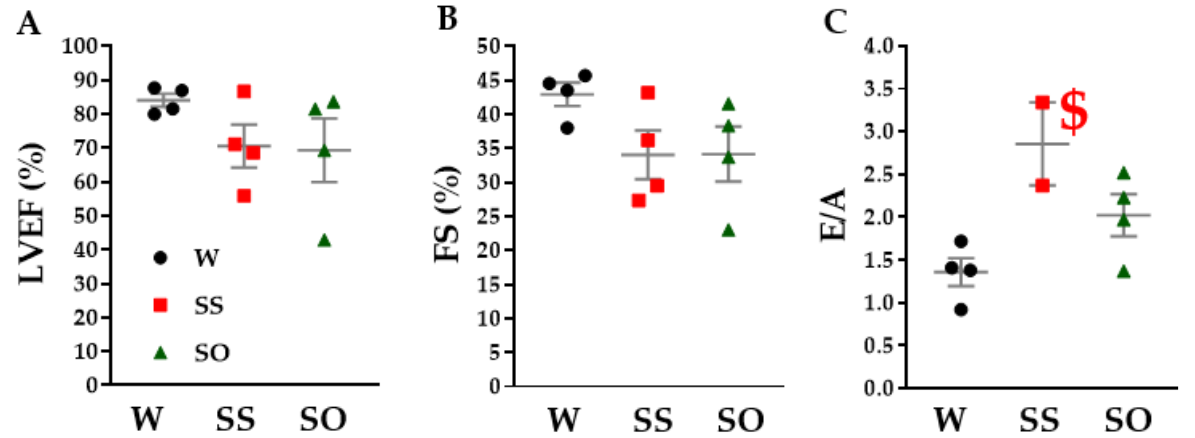
Figure 3. Effects of human omentin-1 on heart failure in SHR. Male SHR (65 – 68-week-old) were subcutaneously injected with saline (0.14 mL/day; SS) and human omentin-1 (18 μ g/kg/day; SO) by using an implanted osmotic pump for 14 days. Male WKY were sham operated (W). ( A ) The left ventricular ejection fraction (LVEF, n = 4, %), ( B ) fractional shortening (FS, n = 4, %), and ( C ) the ratio between velocities of early diastole (E) and late diastole (A) inflow across mitral valves (E/A, n = 2) were measured with echocardiography. The results were expressed as means ± S.E.M. LVEF was calculated via dividing (LVEDV − LVESV) by LVEDV. FS was calculated via dividing (LVDd − LVDs) by LVDd. LVEDV; left ventricular end-diastolic volume, LVESV; left ventricular end-systolic volume, LVDd; left ventricular end-diastolic diameter, LVDs; left ventricular end-systolic diameter. $ E and A wave could not be calculated (n = 2). Statistical evaluations were performed using a One-way ANOVA followed by Bonferroni’s post-hoc